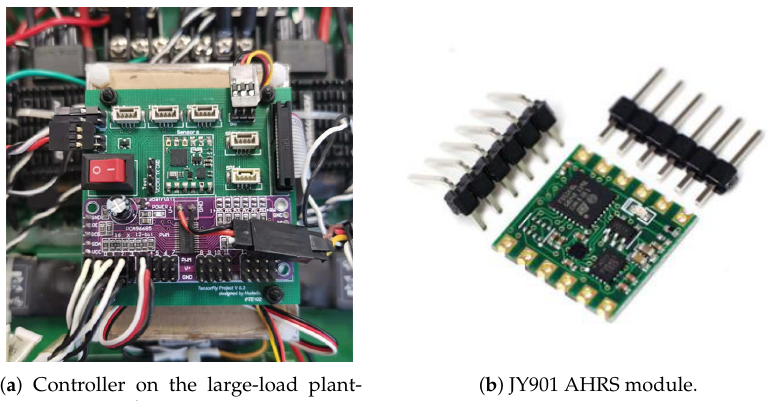
Figure 13. Flight controller platform TensorFly Project